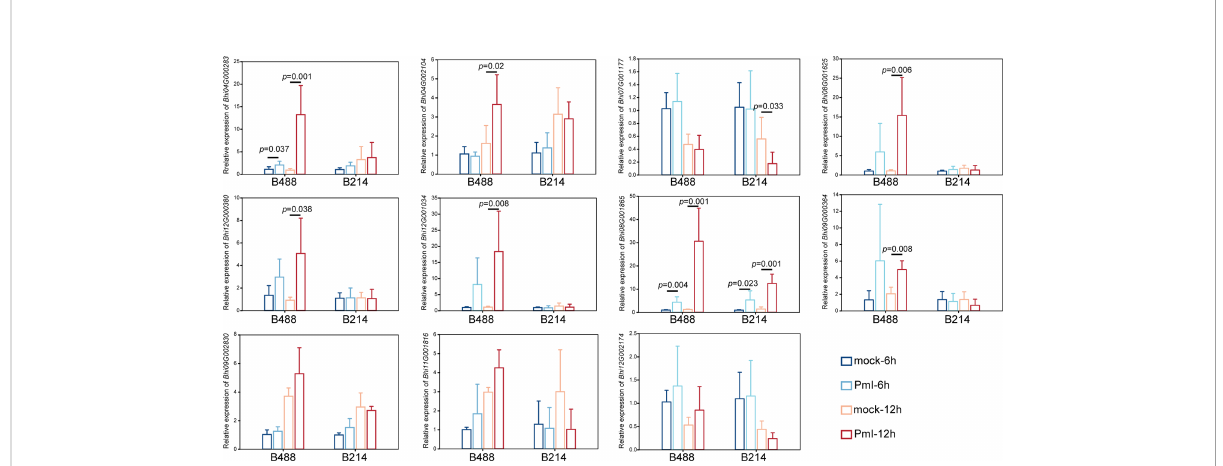
FIGURE 7 Expression pattern of TF genes. A P. melonis zoospore suspension (10 5 zoospores per milliliter) was sprayed on surface of B488 and B214 leaves, sterilized water was sprayed on surface of B488 and B214 leaves as the control; leaves were harvested at 6 h and 12h for RNA extraction and subsequent qRT-PCR analysis, six biological replicates were performed, p value was determined using Fisher ’ s protected LSD